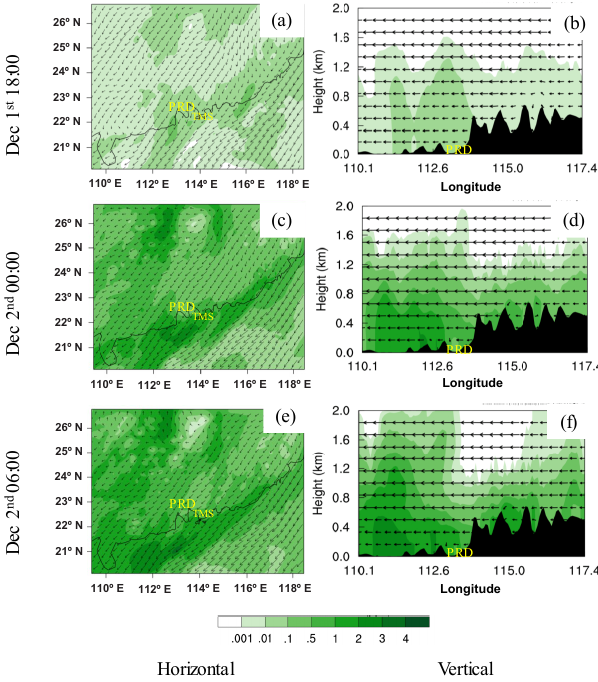
Figure 5. The same as in Fig. 4, except in the night of 3/4